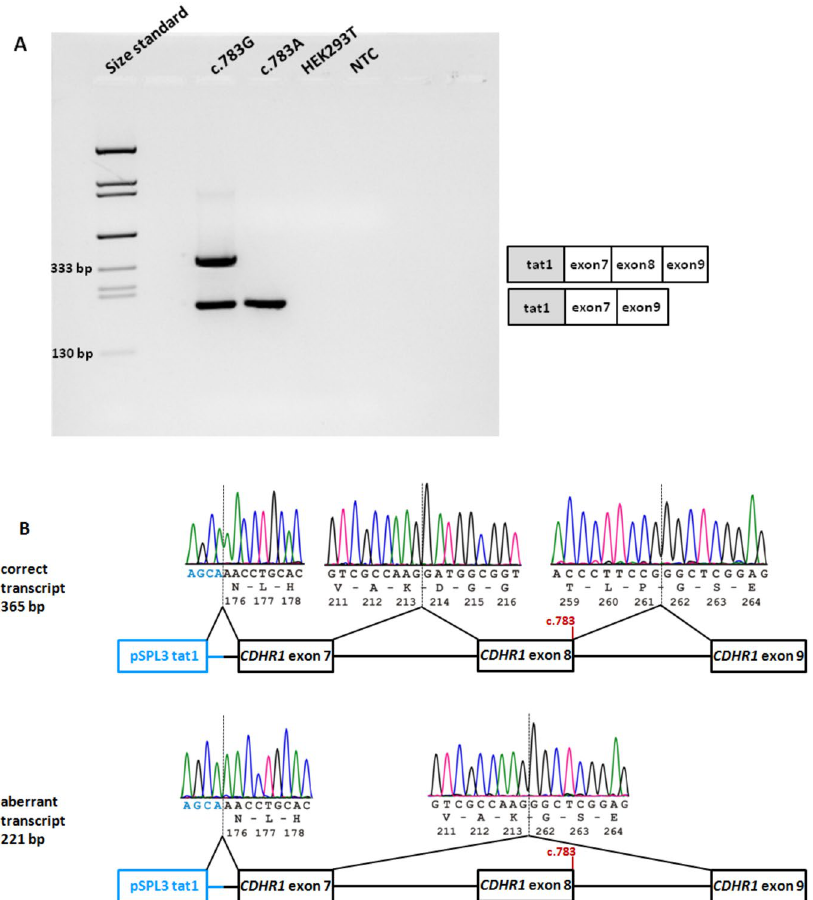
Figure 3. In vitro splicing assay for the c.783 G > A variant. ( A ) RT-PCR revealed two products in HEK 293 T cells transfected with the wild-type construct and a single RT-PCR product for the mutant construct. Untransfected cells served as control. NTC, non-template control. Schemes of the amplified products are presented on the right of the agarose gel. Grey boxes represent pSPL3 exons and white boxes CDHR1 exons. ( B ) Sequence analysis showing that the aberrant product results from skipping of exon 8. The position of the c.783 variant is depicted in red. The junction of CDHR1 exon 9 and pSPL3 tat2 could not be shown since a reverse PCR primer was used that binds within exon